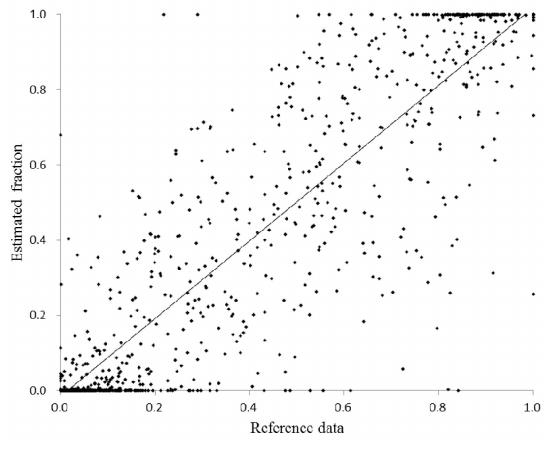
Figure 8. The relationship between estimates from SDI and corresponding cropland fraction reference data from Landsat TM data in